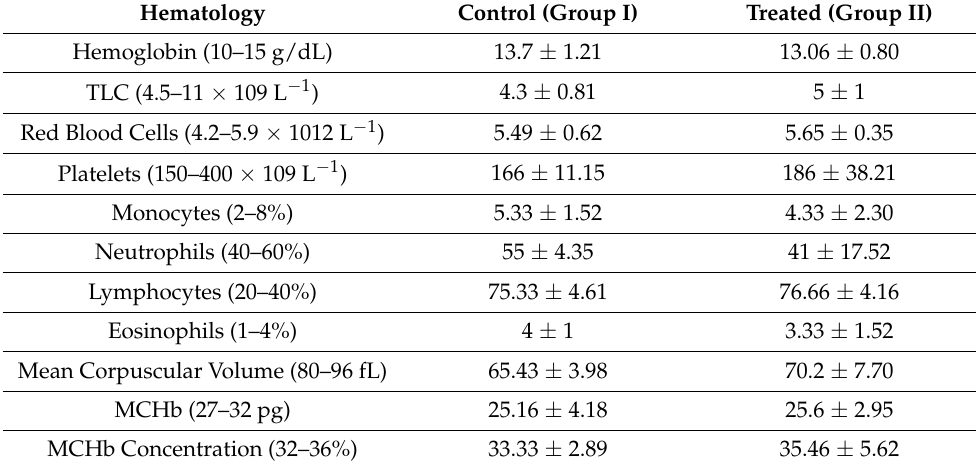
Table 6. Biochemical blood analysis.